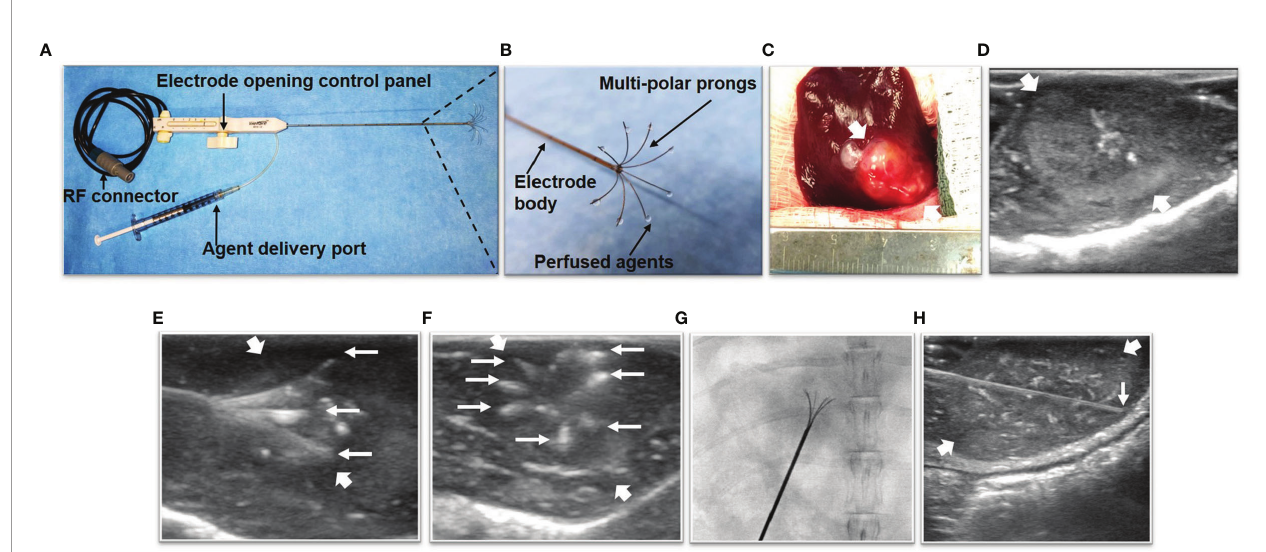
FIGURE 2 | The multi-functional perfusion-thermal radiofrequency (RF) electrode, treatment process of liver tumor, and in-vivo interventional optical imaging process of liver tumor. (A) The multi-functional perfusion-thermal RF electrode with multipolar agent infusion prongs. Micro-thermosensors are equipped at the tips of the prongs for real-time measurement of RFH at approximately 42°C. (B) The details of RF electrode tip. (C) Morphology image of tumor (arrow) during surgery, which is detected by ultrasound imaging (D) . The perfusion-thermal electrode is advanced into the center of the tumor (between large arrows) under real-time ultrasound guidance. (E) Longitudinal and (F) transverse sonographic images, showing the electrode prongs (small arrows). The electrode prongs (small arrows) are opened to the desired size array, further con fi rmed by X-ray image (G) , to completely cover the tumor peripheral zone for suf fi cient delivery of the therapeutic agent. During delivery of LTX-401, RFH at the tumor is generated with the same device to further enhance oncolytic treatment. (H) Under real-time ultrasound imaging guidance, the micro-OI needle (small arrow) was advanced into the periphery of the tumor (between large arrows), to generate intratumoral “ inside-output ” optical images at different directions/points around the tumor